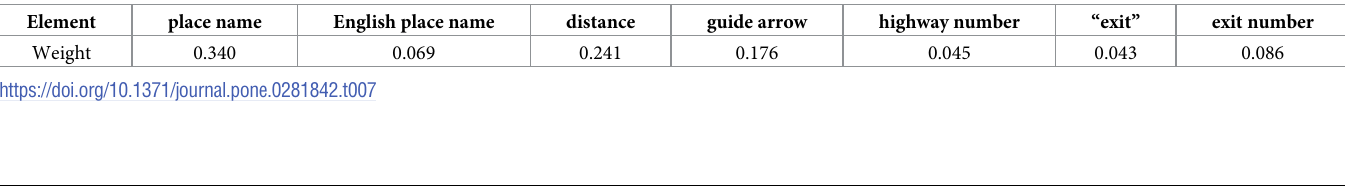
Table 7. According to Table 7, it can be obtained that the weights of components such as highway number and exit are relatively low, and place name has the largest weight, which means it is indispensable. Therefore, we constructed 12 types of exit advance guide signs, with different amounts of information, combined with the place name, distance, guide arrow, English place name, and exit number. At the same time, considering that Chinese place names consist mainly of two or three characters, while setting up the experiment, in addition to the amount of information, the number of place names was used as a variable to explore the influence rule of exit advance guide signs with different words on the total time of drivers’ observation, read- ing, and reaction. According to the requirements of Road Traffic Signs and Markings (GB5768-2009) and The Technical Guide for Adjustment of Traffic Signs in National Highway Network (Ministry of Transport, 2017), 12 categories of advance guide signs were drawn. The height h of Chinese characters was 55 cm, the height of characters from the edge of the sign was 1/2 h, and the word interval was 1/10 h. Each type of exit advance guide sign had six-, two- , and three-character place names, for a total of 144 signs. The place names were all from the mountainous areas in China and contained no uncommon characters. To maintain the same amount of information in different sign combinations, place names with the same number of letters were selected (e.g., “Shui Jiang” and “Yong chuan” are both composed of two Chinese characters and nine letters). For signs with an exit distance, 500 m was chosen. Exit numbers on signs were randomly selected from the national highway network. The layout form and information content of signs with different combinations of elements are shown in S1 File.